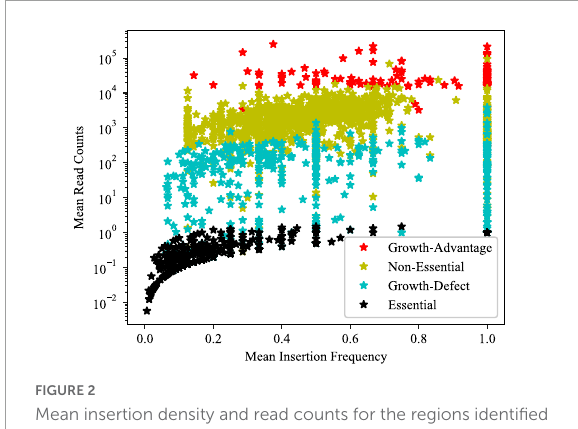
FIGURE2 Mean insertion density and read counts for the regions identified by HMM. This graph illustrates the distribution of non-zero read counts and insertion frequencies for the regions identified by HMM that are defined as consecutive sites belonging to the same state.